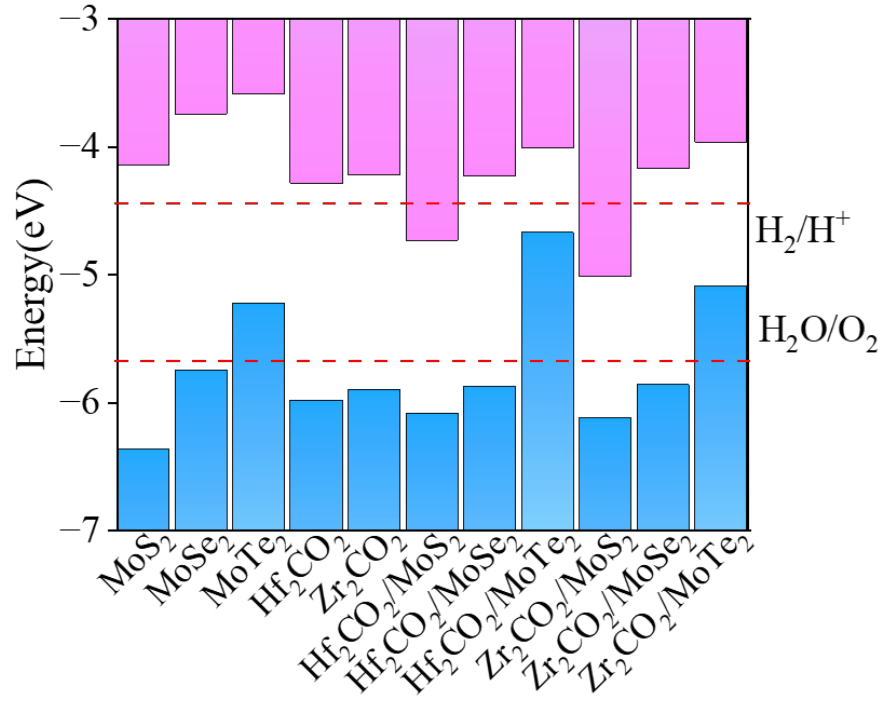
Figure 7. Band edge alignments of the M 2 CO 2 , MoX 2 monolayers, and M 2 CO 2 /MoX 2 vdW heterostructures.